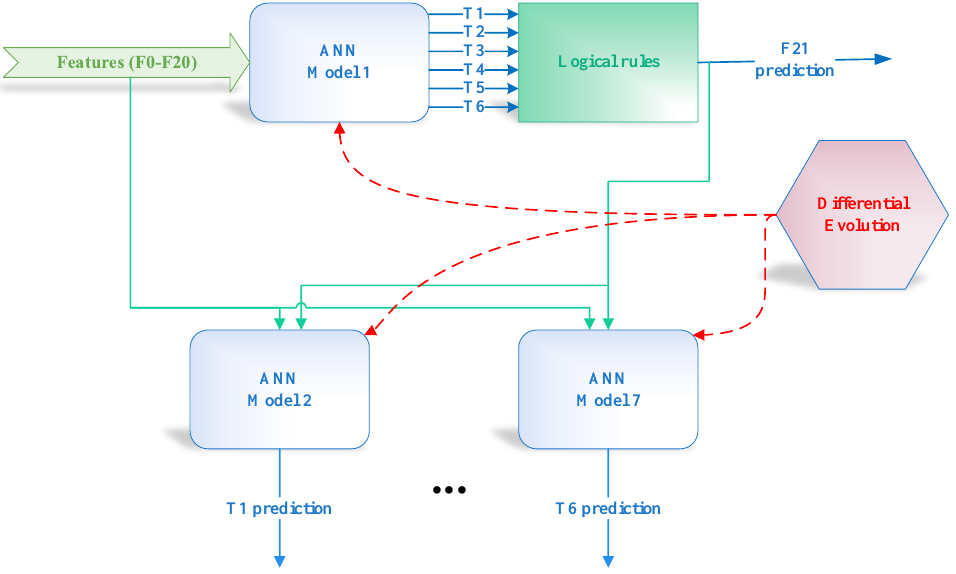
Figure 2. Modeling strategy for phase transition temperatures.